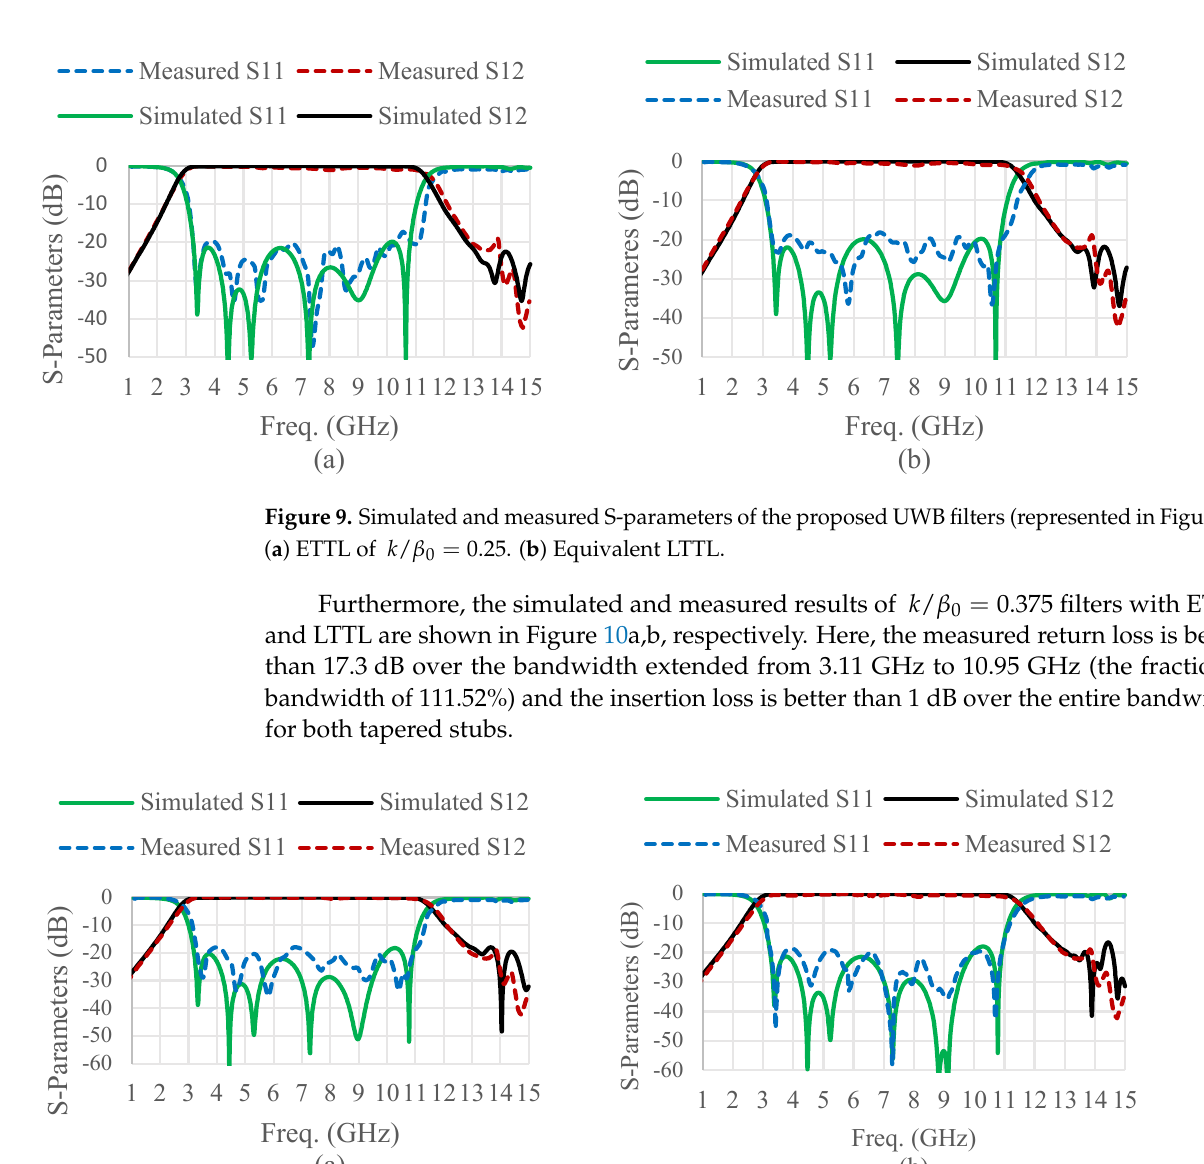
Figure 10. Simulated and measured S-parameters of the proposed filters (represented in Figure 6). ( a ) ETTL of k / β 0 = 0.375. ( b ) Equivalent LTTL. In addition, for k / β 0 = 0.50, the return loss is better than 17 dB and the bandwidth extends from 3.09 GHz to 10.99 GHz (the fractional bandwidth of 112.22%) with an insertion loss less than 0.8 dB over the entire bandwidth for both stubs, as shown in Figure 11. Moreover, the obtained measurement results show a group delay that is almost flat over the entire passband bandwidth, as can be seen in Figure 12. The measured group delay is less than 0.8 ns and measured directly using the vector network analyzer. The photograph of the fabricated filter with k / β 0 = 0.25 is shown in Figure